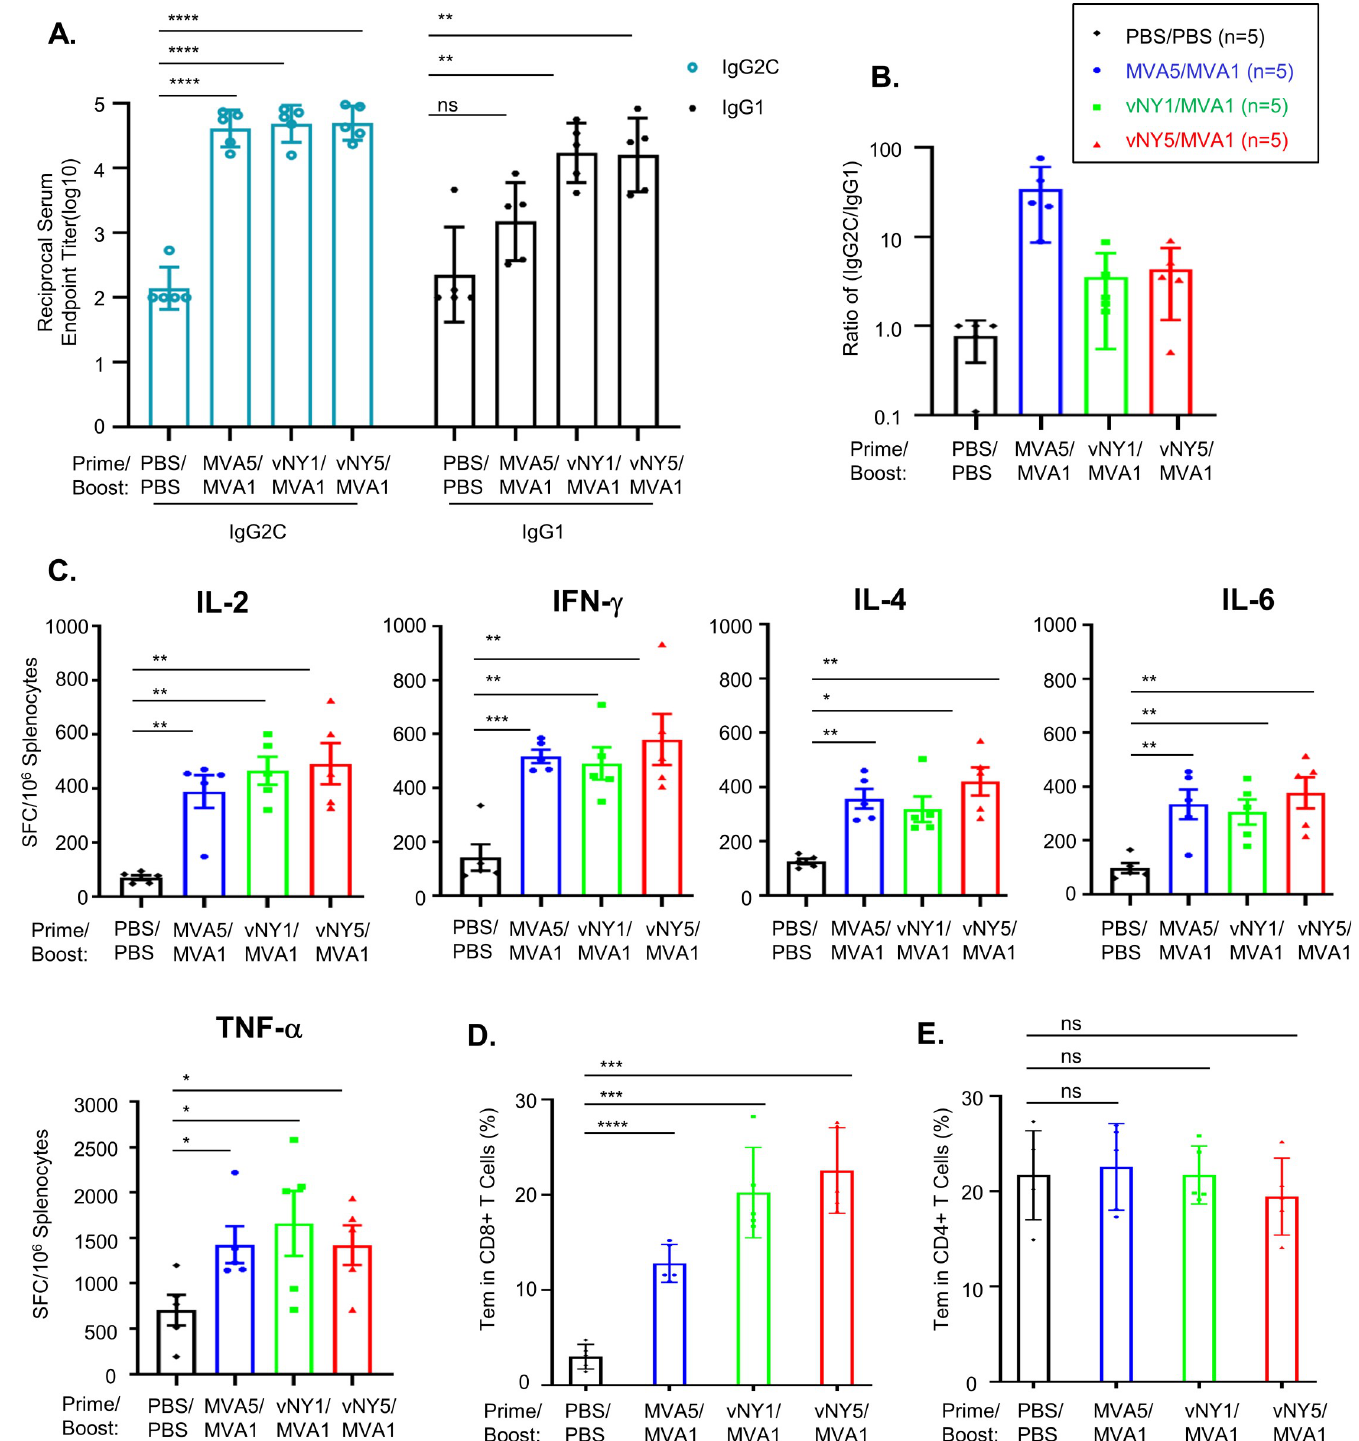
Fig 3. MVA5/MVA1, vNY1/MVA1 and vNY5/MVA1 vaccination regimens induce T H 1-biased immune responses. (A). End-point titers of SARS-CoV-2 spike- specific IgG2C and IgG1 antibodies in mouse sera collected 2 weeks after vaccination regimens. ns-not significant; �� p < 0.01; ���� p < 0.0001. (B). End-point titer IgG2C/ IgG1 ratio calculated based on data from (A) (n = 5 for each group). (C). ELISpot analyses of mouse splenocytes collected 4 weeks after vaccination regimens for their expression of IL-2, IFN- γ , TNF- α , IL4 and IL6 cytokines (n = 5 for each group). Data represented as mean ± SEM. SFC–spot-forming cells. � p < 0.05; �� p < 0.01; ��� p < 0.001. (D & E). SARS-CoV-2 spike-specific CD8 + (in D) and CD4 + (in E) T effector memory cells (CD44 + CD62L - ) in splenocytes, as detected by flow cytometry (n = 5 for each group). Data represented as mean ± SD. ns–not significant; ��� p < 0.001; ���� p < 0.0001. https://doi.org/10.1371/journal.pone.0257191.g003 PLOS ONE | https://doi.org/10.1371/journal.pone.0257191 September 9,